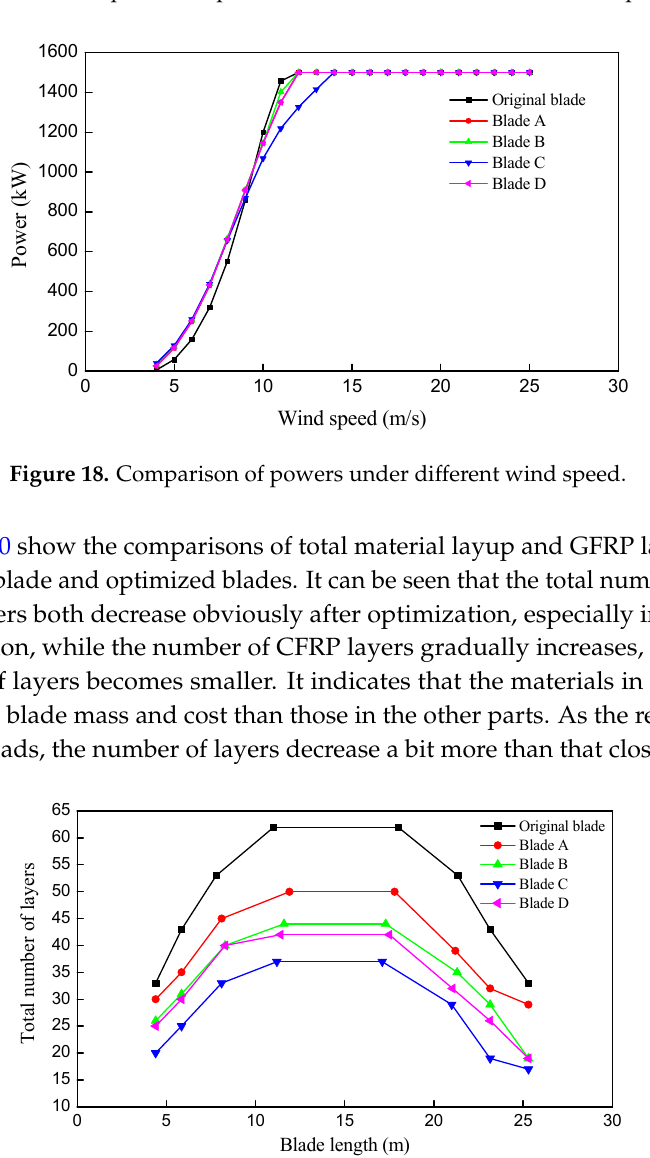
Figure 17. Comparison of power coefficients under different wind speed.